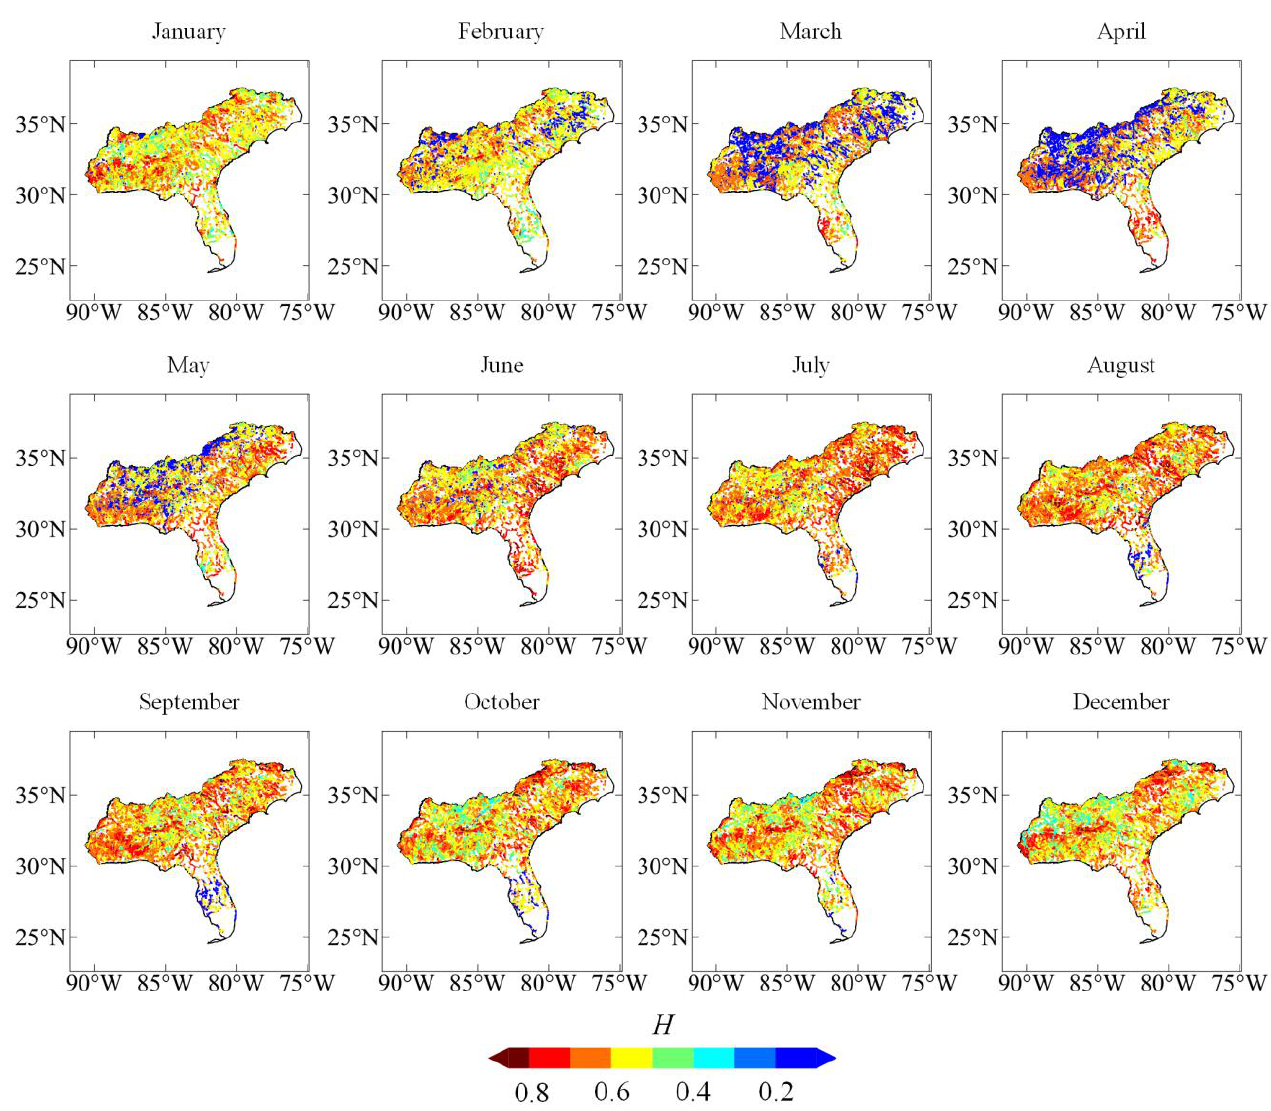
Figure 9. Hurst exponent values for monthly series.